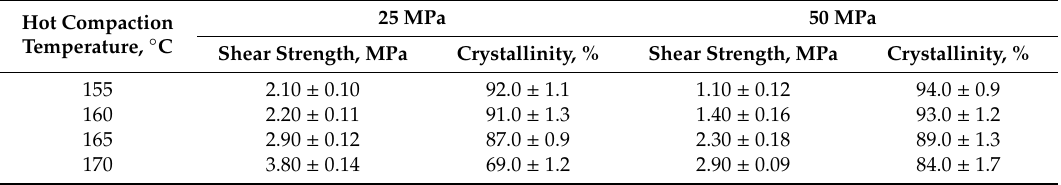
Table 1. Shear strength and crystallinity of the SRC obtained at di ff erent temperatures and